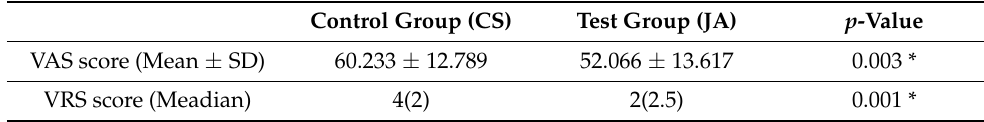
* Statistically significant ( p = 0.001).